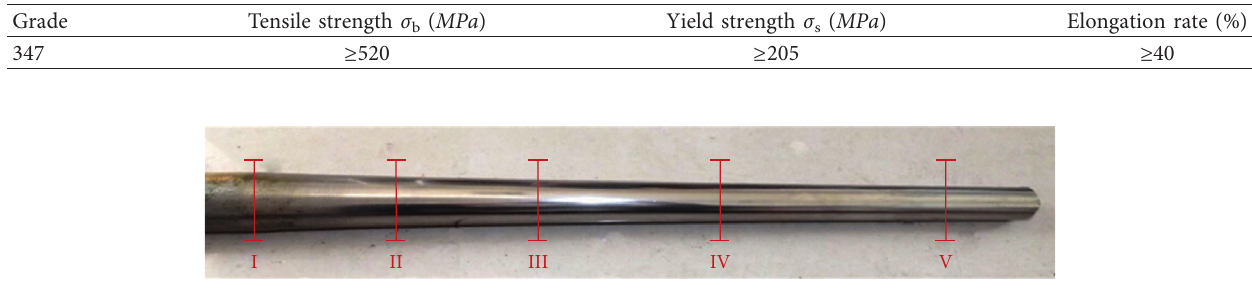
Figure 1: The deformed tube. Table 2: Data of different sections of the deformed tube.